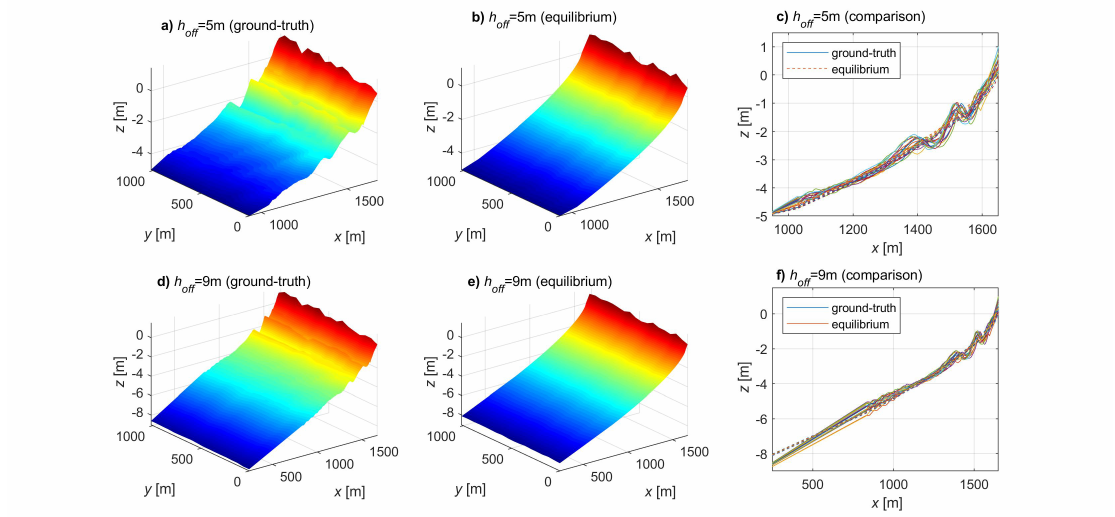
Figure 8. Ground-truth bathymetries ( a , d ) and equilibrium-profile-based bathymetries ( b , e ) relevant to an offshore depth of 5 m (top panels) and 9 m (bottom panels). Comparisons between ground-truth and equilibrium profiles is also illustrated ( c , f